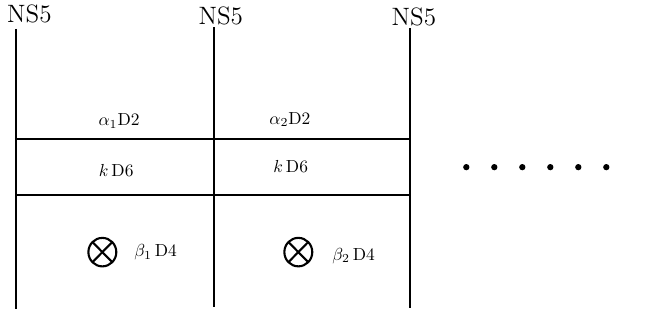
Figure 6 . Generic brane set-up associated to the AdS 3 solutions in [3] with vanishing Romans